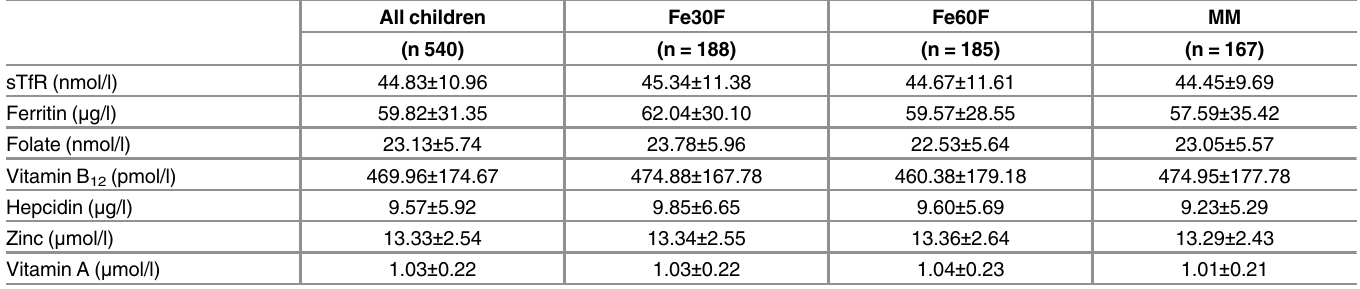
Table 2. Plasma biomarkers in school-age children in rural Matlab.